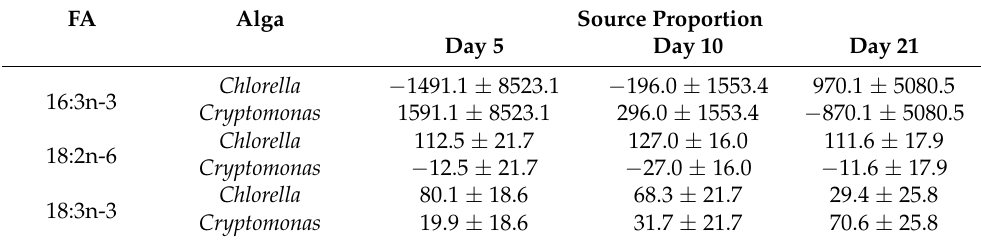
Table 4. Results of calculation by IsoError mixing model using isotope values of three common essential dietary FAs: average proportions of consumption of two algae species (M ± SE, %) by Daphnia at Days 5, 10, and 21 of the